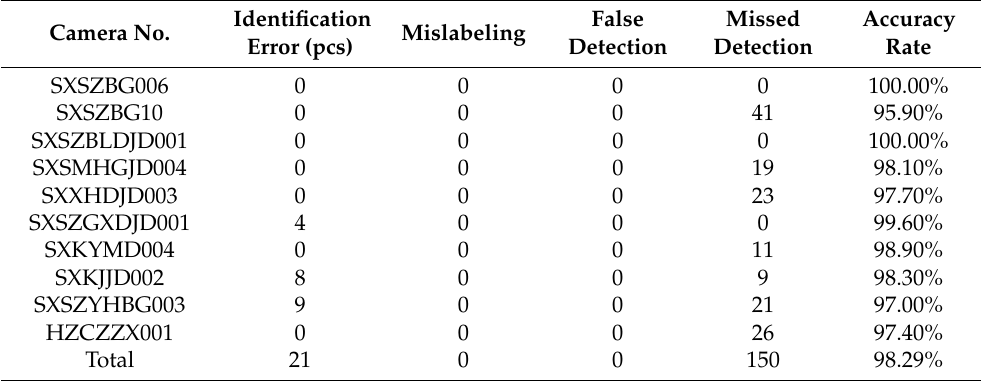
Table 5. Record of the field test